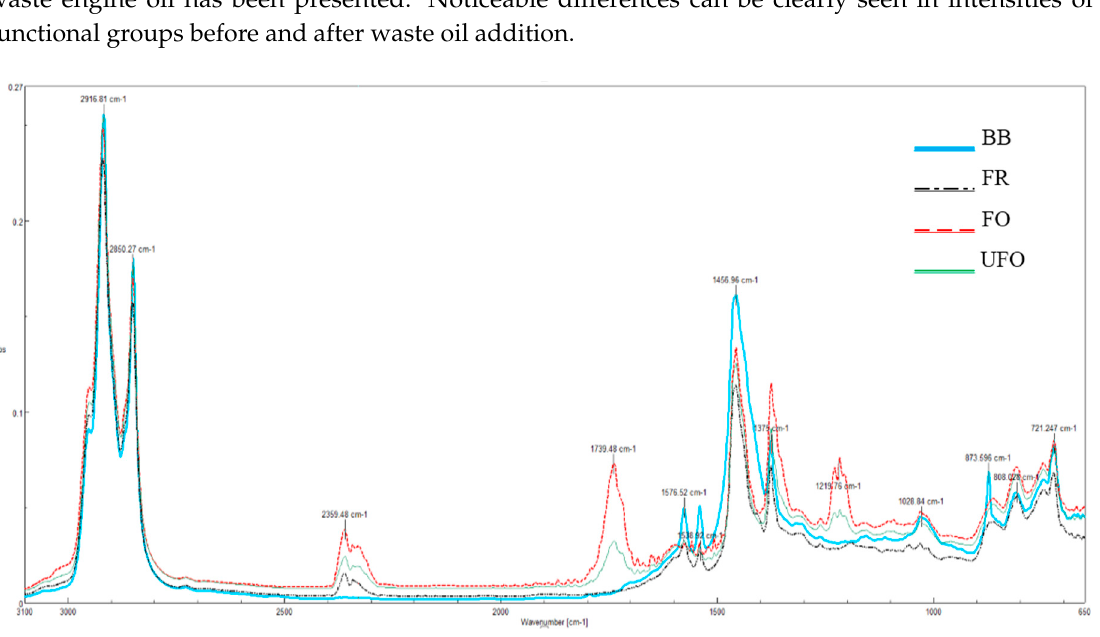
Figure 6. FTIR spectra comparison of RTFO-aged asphalt binders.